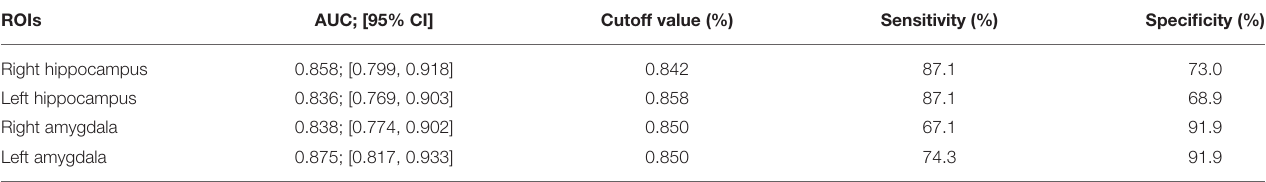
TABLE 4 | Diagnostic performance of APTw values from four regions of interest (ROIs) in predicting aMCI.